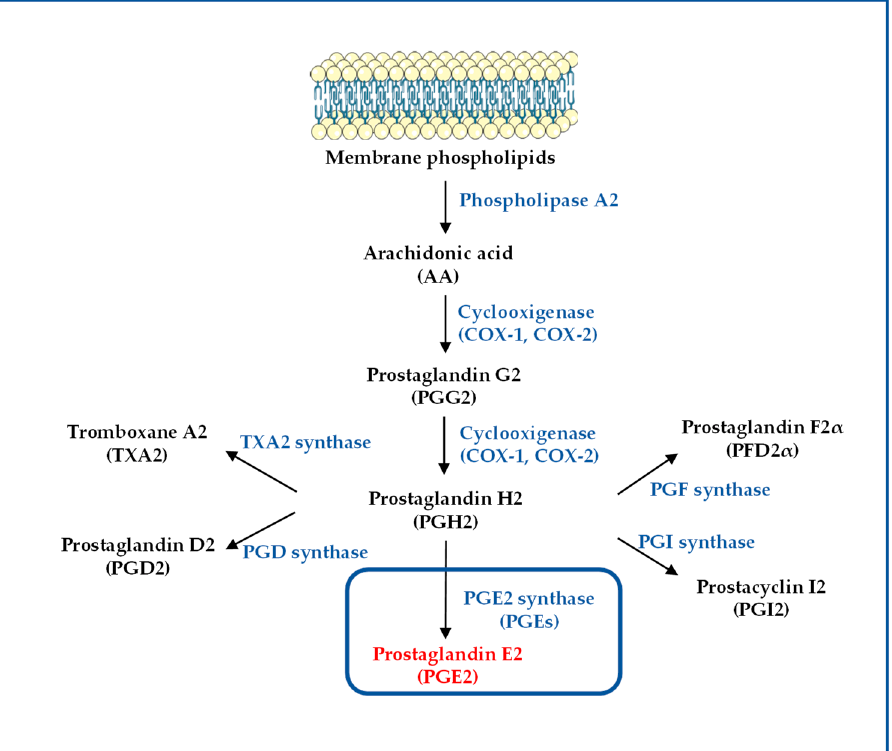
Figure 1. Biosynthesis of prostaglandins. Arachidonic acid (AA) is a phospholipid present in cell membranes and is liberated from the cellular membranes by cytoplasmic phospholipase A2 (PLA2). Free AA is converted to PGE2 through the COX pathway. AA is metabolized to the intermediate prostaglandin G2 (PGG2), which is then reduced to PGH2 by the peroxidase activity of COX. PGH2 is sequentially metabolized to PGE2 or other eicosanoids by specific synthases. Furthermore, the production of all PGs, such as prostaglandin D2 (PGD2), PGE2, prostaglandin F2 α (PGF2 α ), prostacyclin (PGI2), and thromboxane A2 (TXA2), occurs by